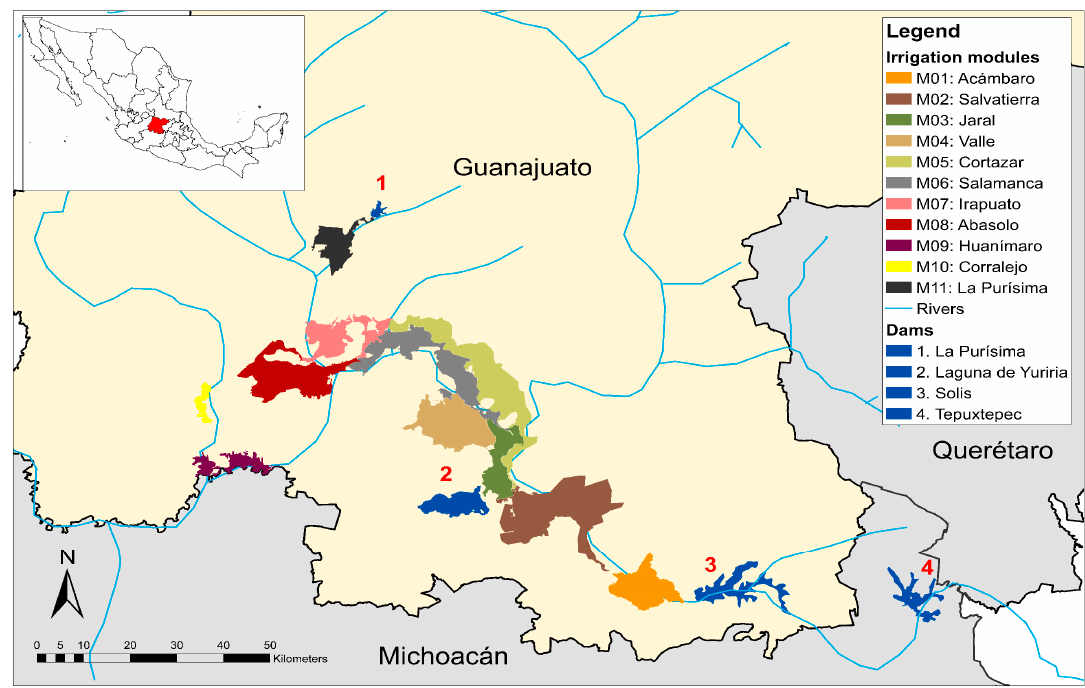
Figure 1 . Irrigation District 011 Alto Rio Lerma in the state of Guanajuato, México. Figure 1. Irrigation District 011 Alto Rio Lerma in the state of Guanajuato, M é